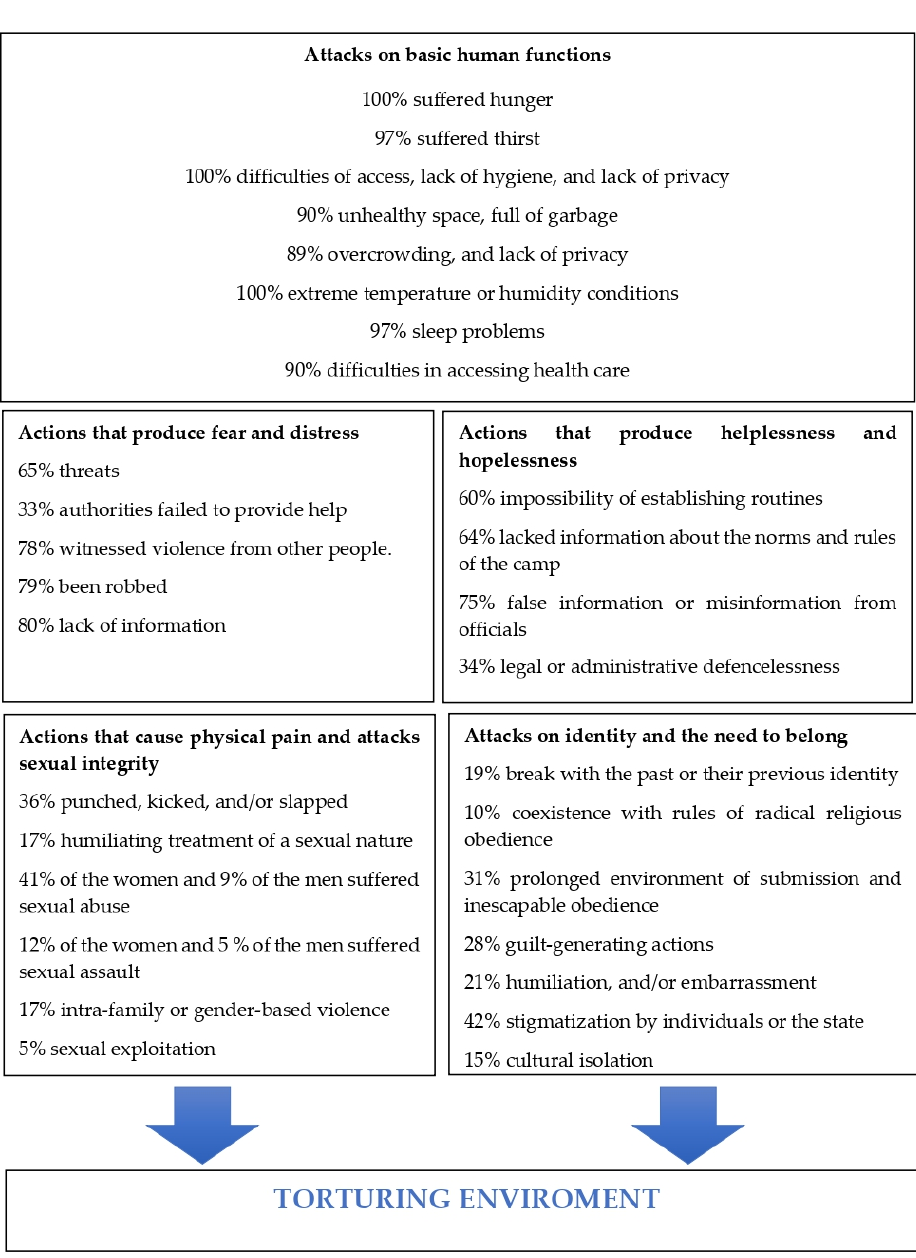
Table 2. Mental health impacts on people in the Moria camp.